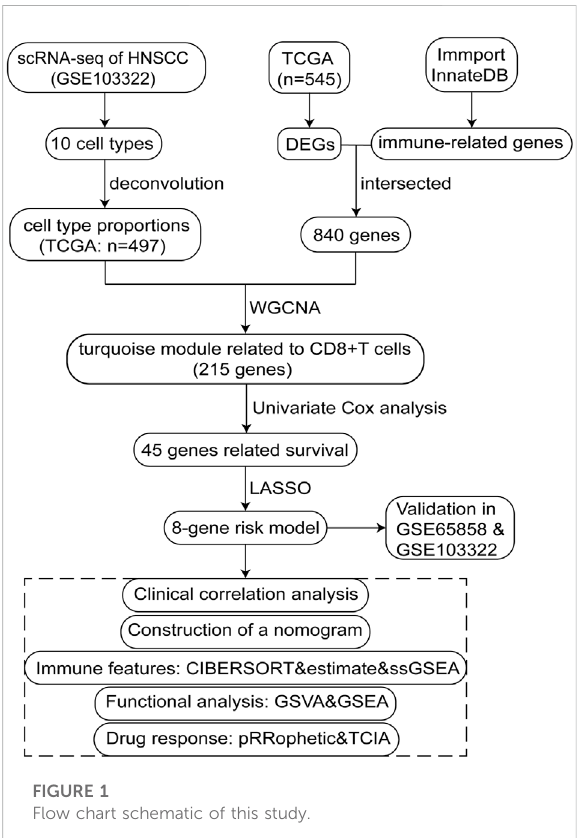
FIGURE 1 Flow chart schematic of this